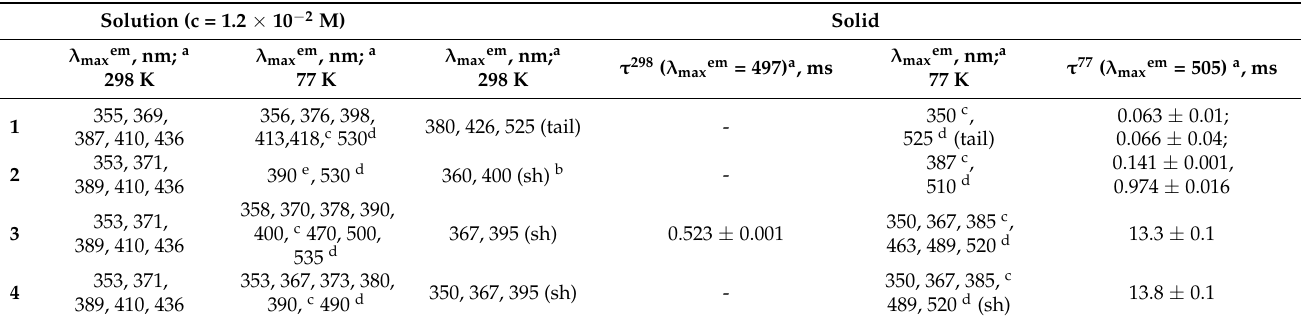
Figure 6. Normalized emission spectra of solid samples 1 – 4 at 298 K (solid lines) and 77 K (dashed lines). Table 1. Photophysical parameters of complexes 1 – 4